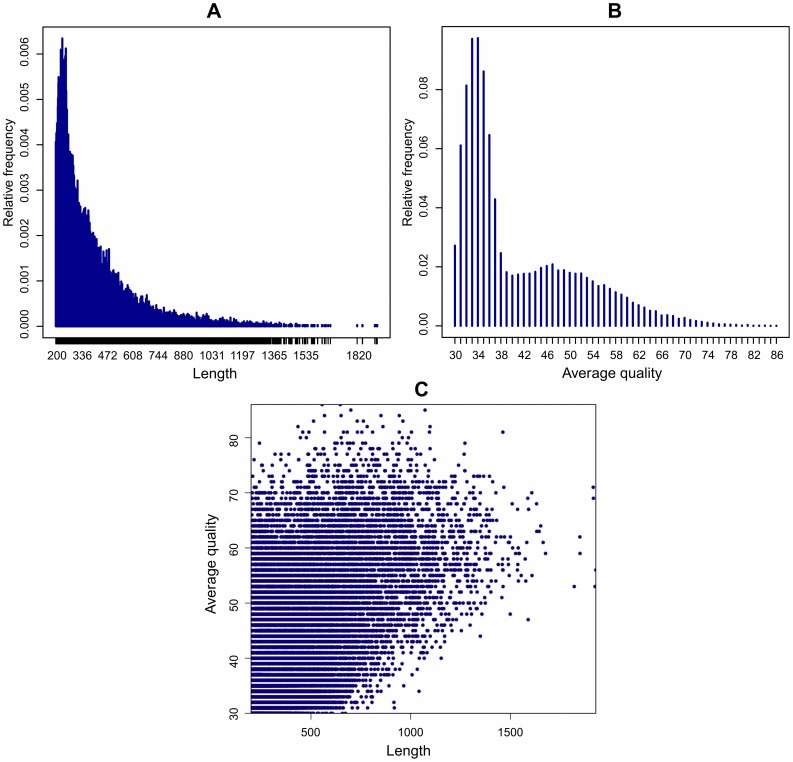
Length and quality of Chamelea gallina transcriptome contigs.Panel histograms report the contig's length (a) and average quality (b) distribution, while panel c shows the relationship between length and quality.